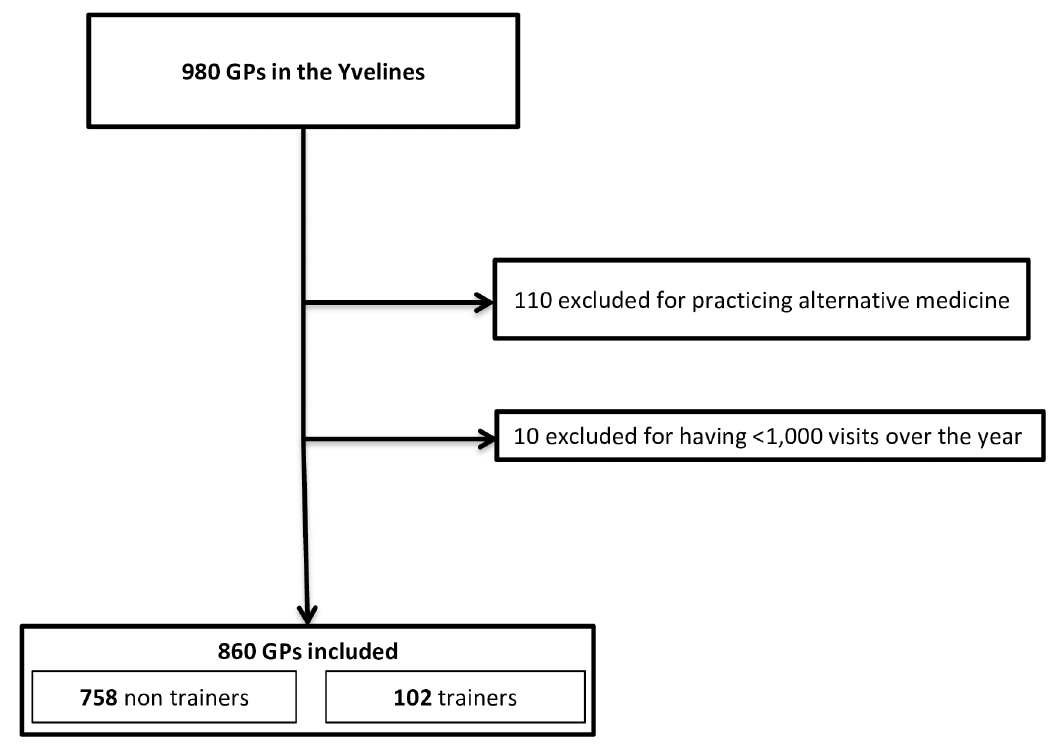
Fig 1. Flow chart of the study